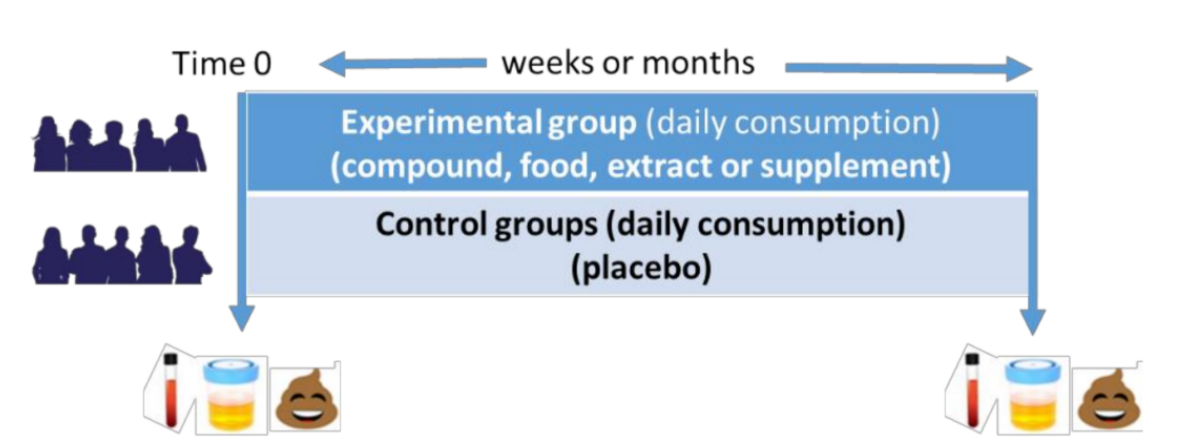
Figure 2. Scheme of a typical longitudinal intervention study carried out in humans.